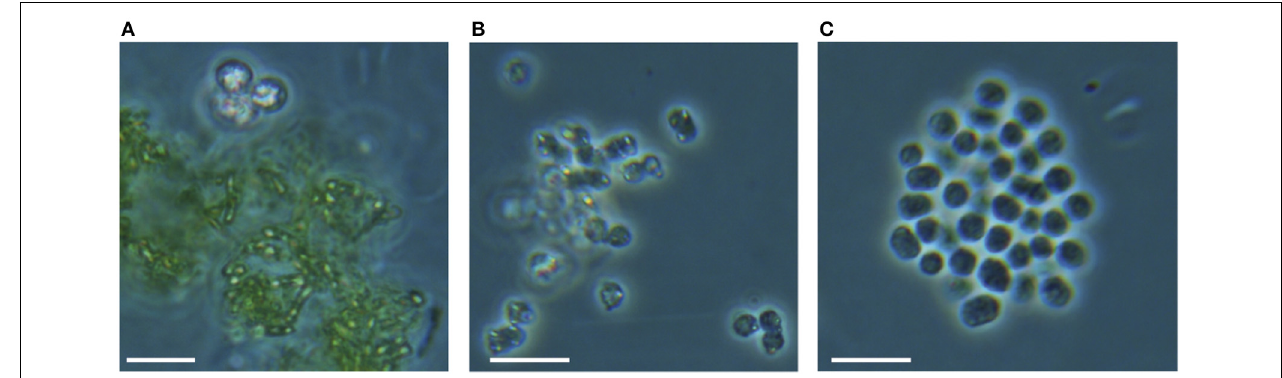
deposited around GSB cells (A,B) . PSB cells without apparent internal S 0 deposits are also frequently observed (C) . Scale bars represent 10 µ